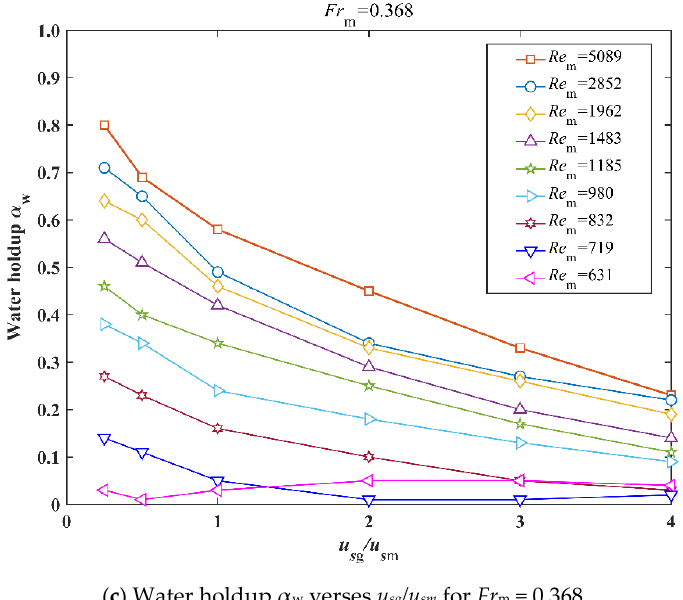
Figure 10. Effect of u sg /u sm on water holdup α w in the vertical section for different Re m values. The input water cut ε w ranged from 10% to 90%. Fr m was fixed at ( a ) 0.105, ( b ) 0.216, and ( c ) 0.368.